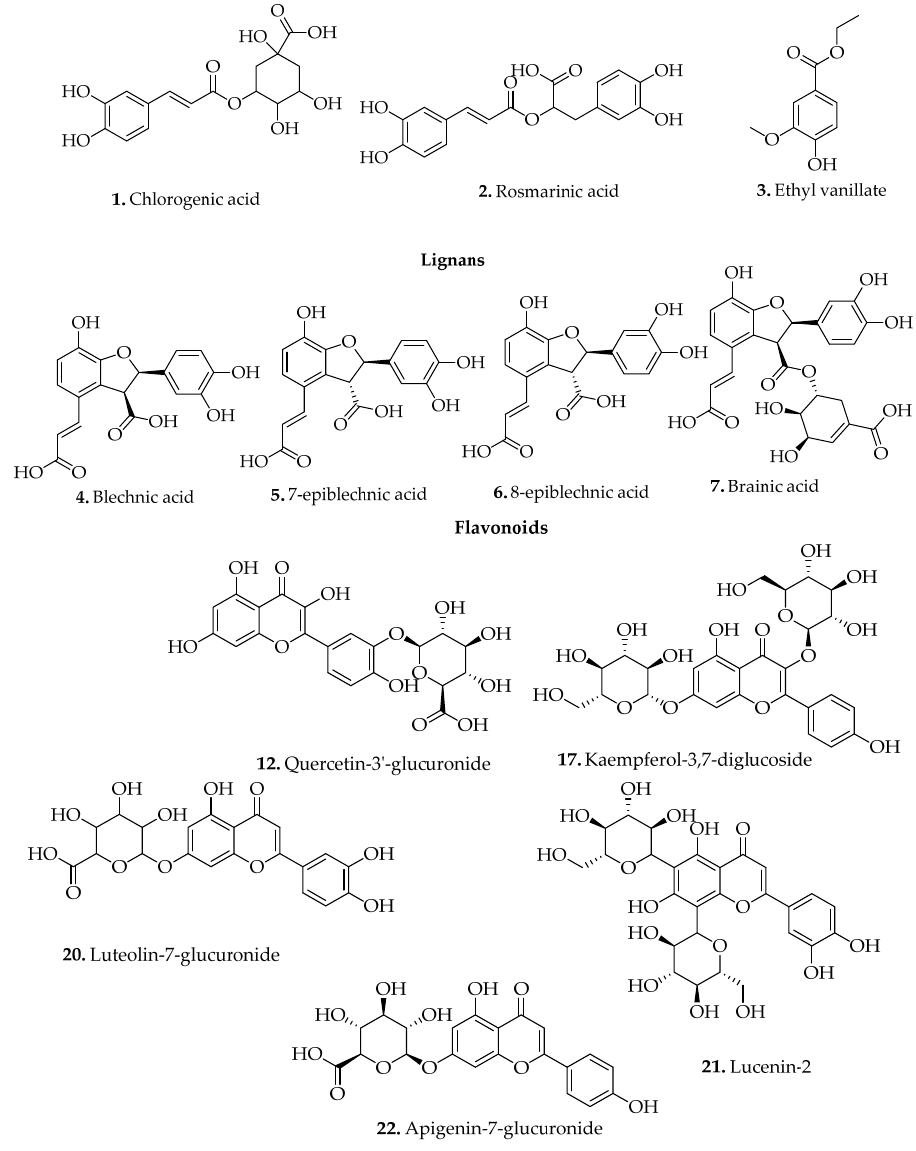
Figure 6. Chemical structures of some phenolic compounds isolated from Blechnum species.